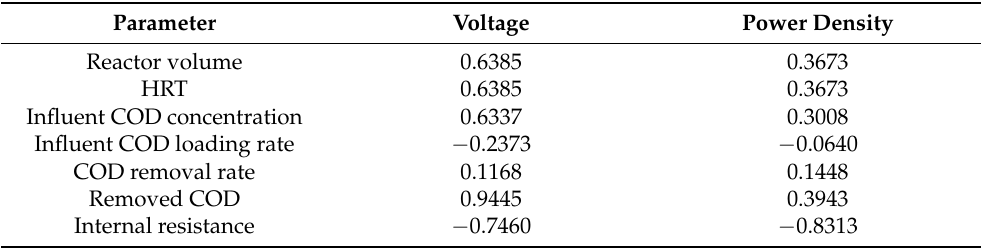
Table 2. Pearson correlations of voltage and power density with the coulombic efficiency, energy recovery, reactor volume, hydraulic retention time (HRT), influent chemical oxygen demand (COD) concentration, influent COD loading rate, COD removal rate, removed COD concentration, the ratio of anode area for reactor volume, and internal